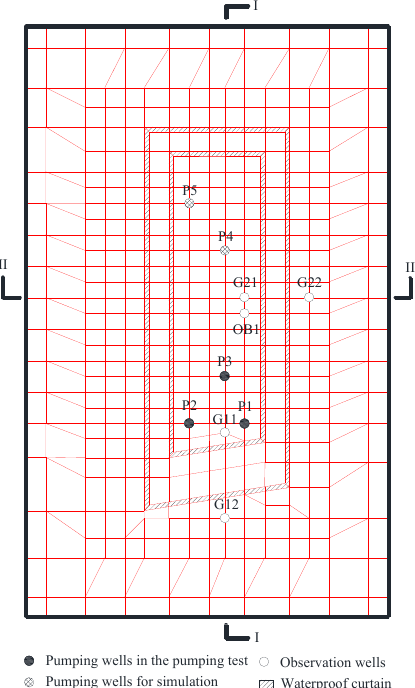
Figure 6. Plan view of local enlarged mesh inside the foundation pit.